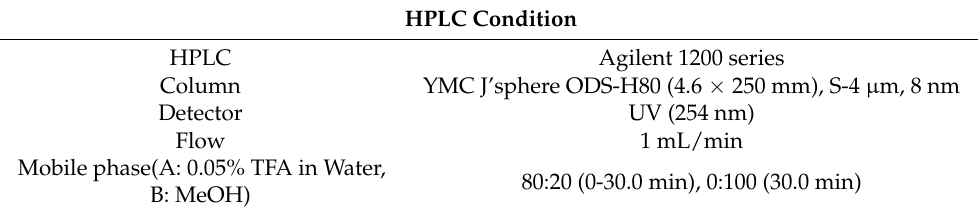
Table 1. Torilis japonica extract HPLC Analysis Conditions.